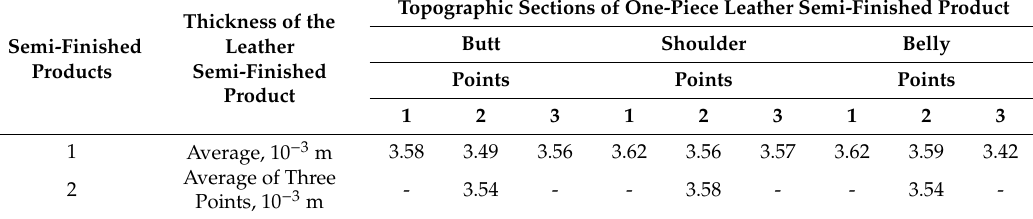
Figure 1. Topographic sections of a one-piece leather semi-finished product. Table 1. Thickness of the leather semi-finished products in topographic sections after tanning and bifurcation. Table 2. Average strain in the materials from the force of compression pressure.